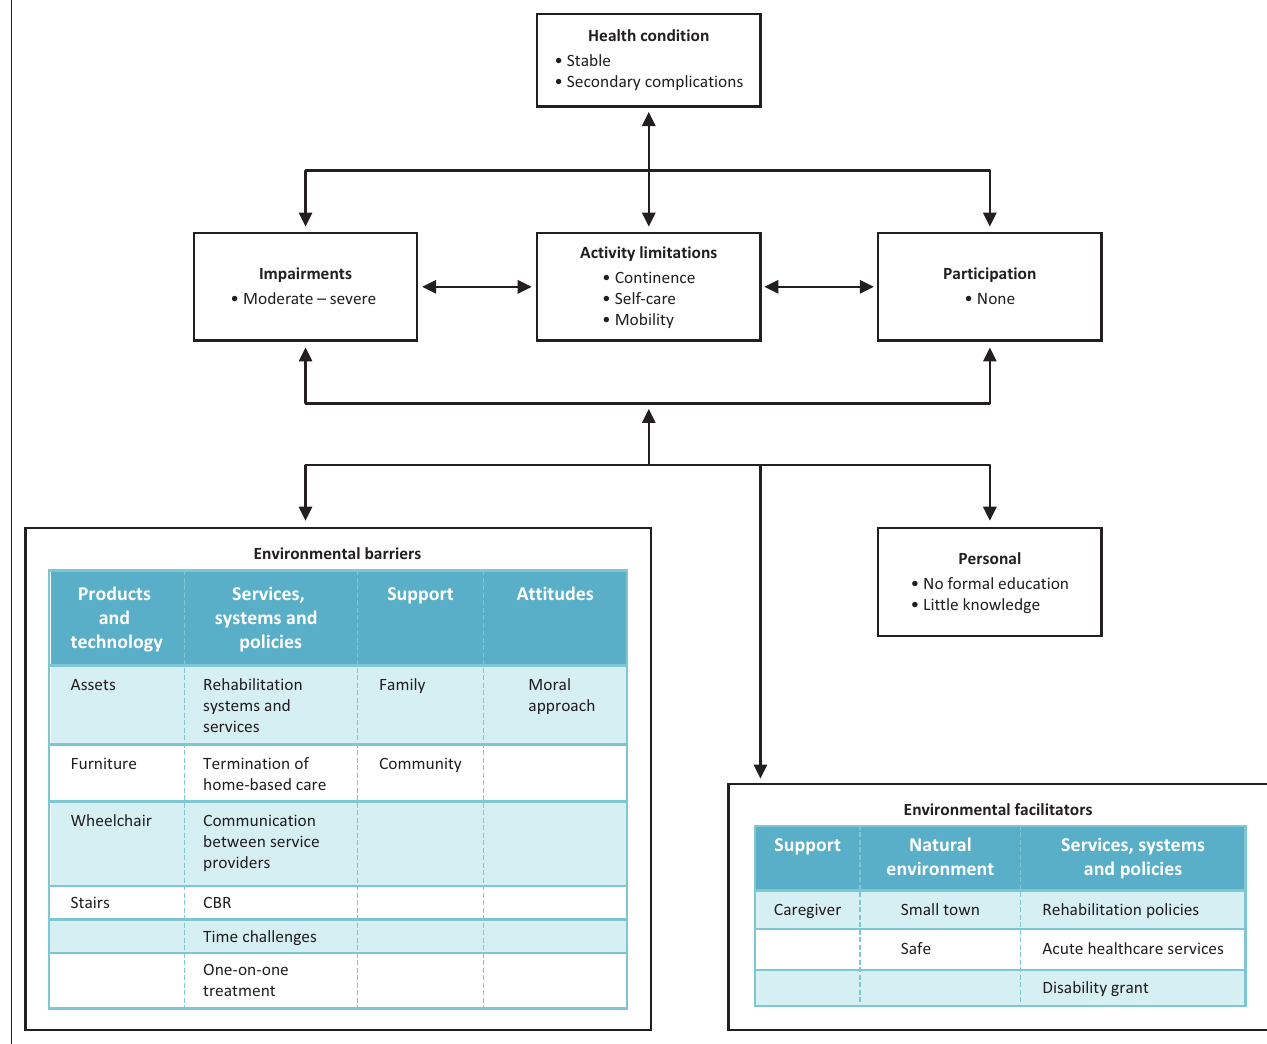
FIGURE 1: Interaction between domains according to the International Classification of Functioning, Disability and